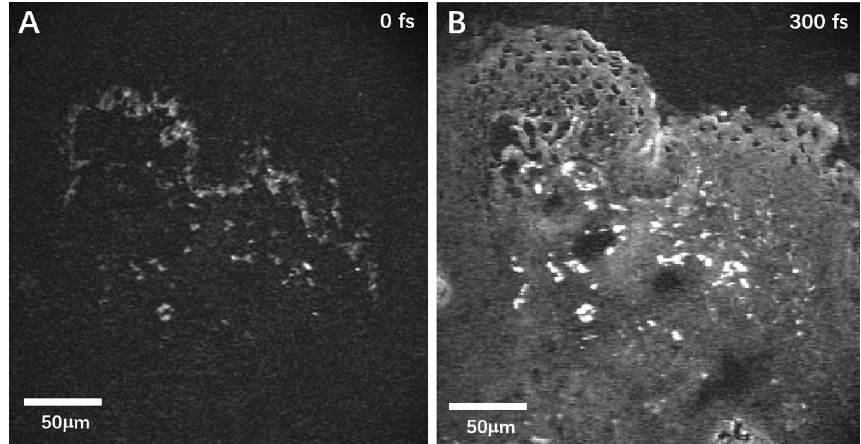
Figure 3. Pump-probe raw images of the lower eyelid skin section. ( A ) Pulse interval 0 fs. ( B ) Pulse interval 300 fs.